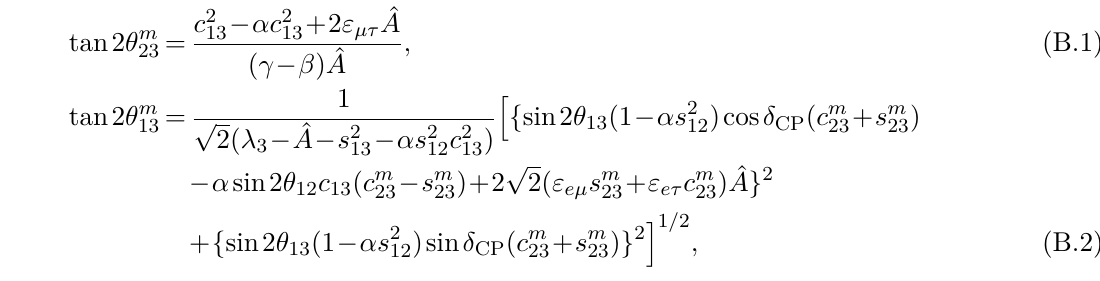
one-at-a-time. In the upper panels, µτ . The three different columns µτ